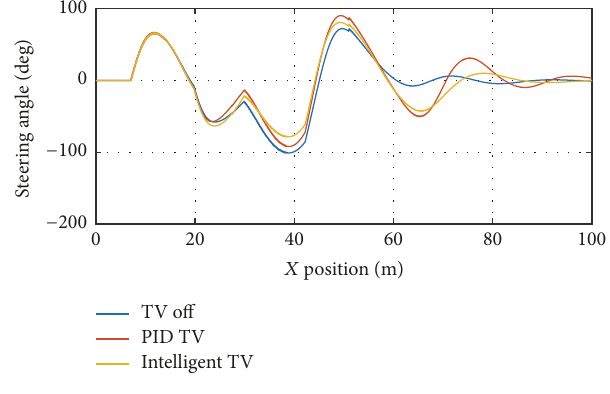
Figure 15: Vehicle lateral acceleration.